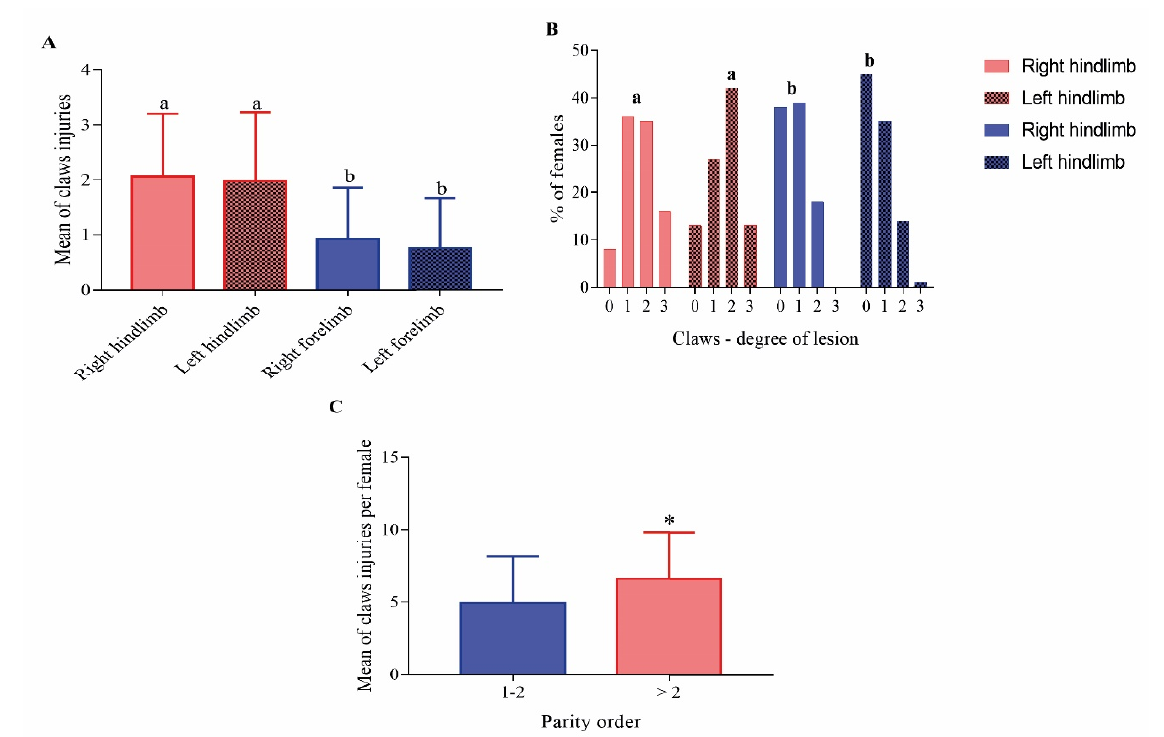
Figure 3. ( A ) Claw injuries according to mean of claws’ injuries in locomotor forelimb and hindlimb; ( B ) claw injuries according to the degree of the lesion in locomotor forelimb and hindlimb; 0: no claws injuries; 1: claws with a discrete lesion; 2: claws with a moderate lesion; 3: claws with a severe lesion; ( C ) claw injuries according to parity order. Within graphics means without a common superscript (a-b or *) differed statistically ( p < 0.05).